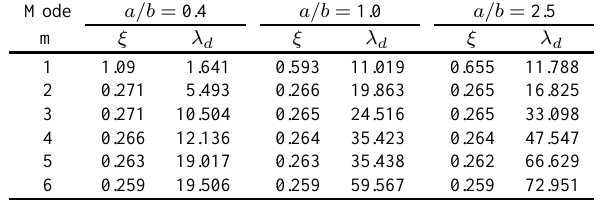
Dimensionless damping ratios and damped frequency parameters λ